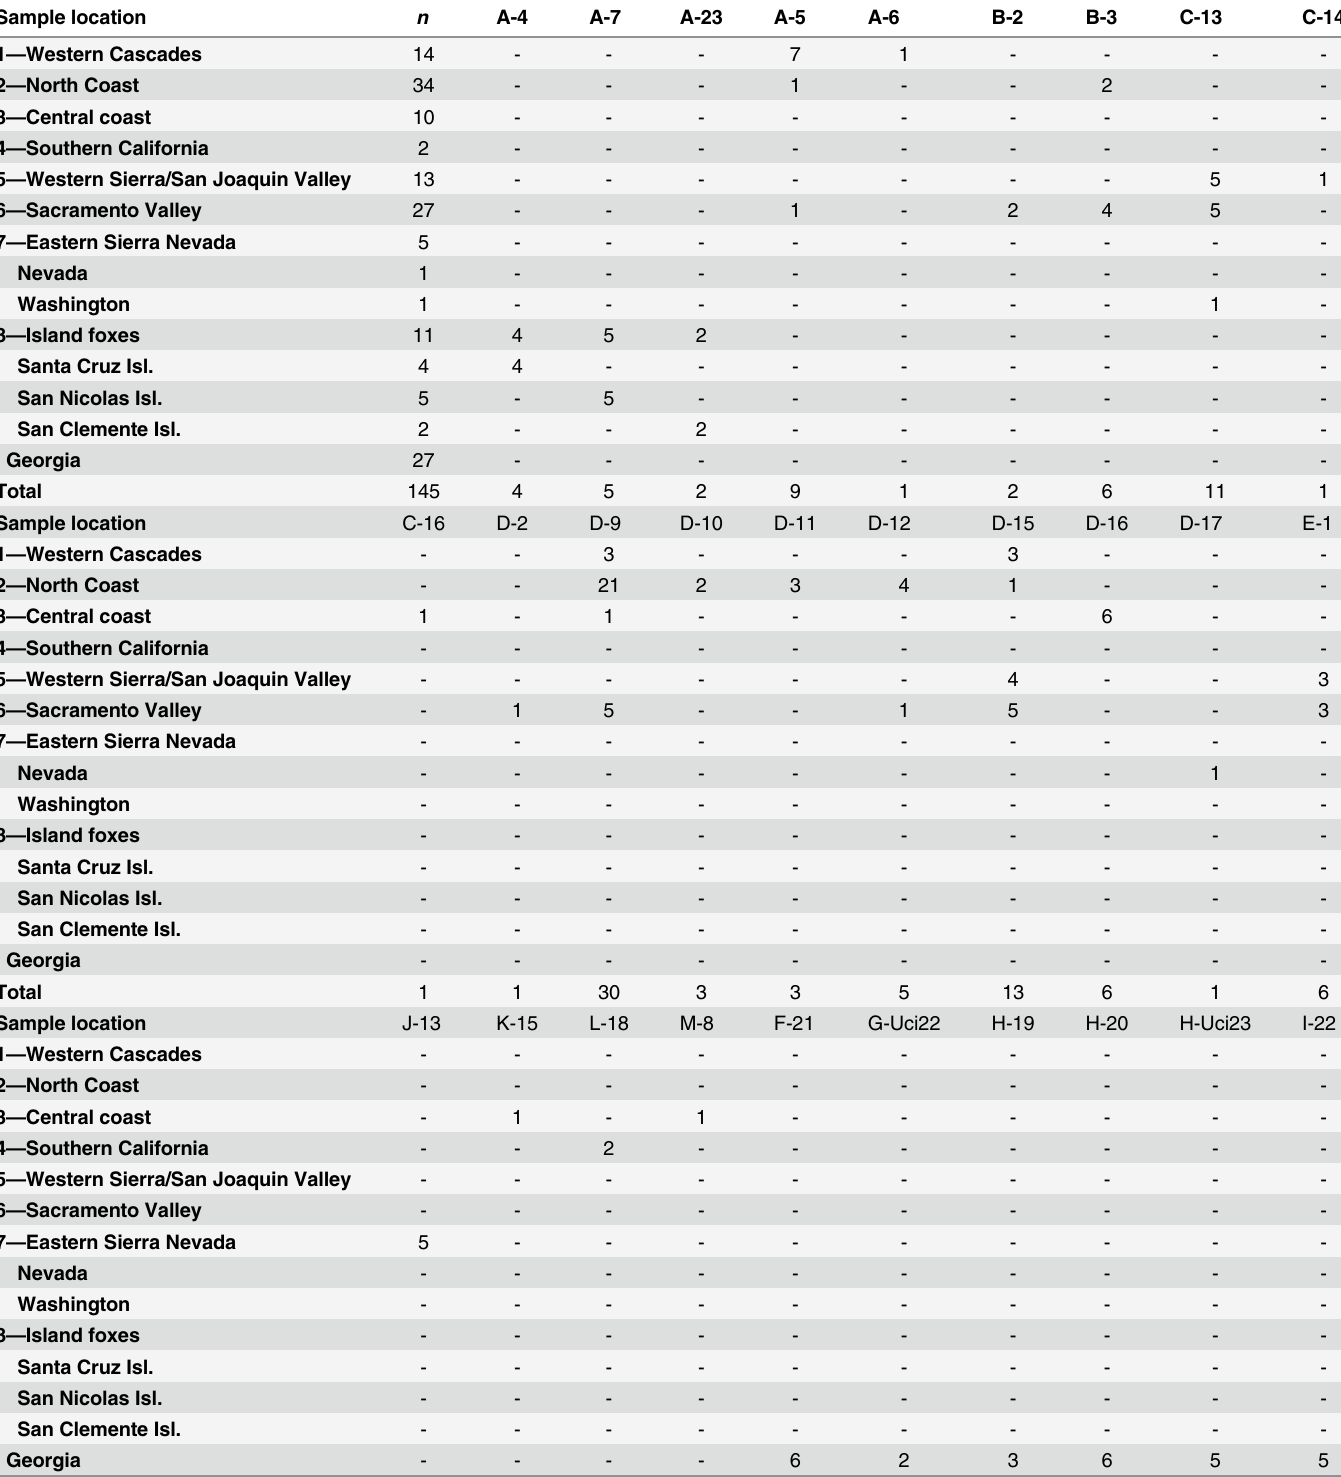
Table 1. Occurrence of 29 concatenated 785 bp cytochrome b and D loop haplotypes among 10 gray fox and 3 island fox sampling locations. Sample location